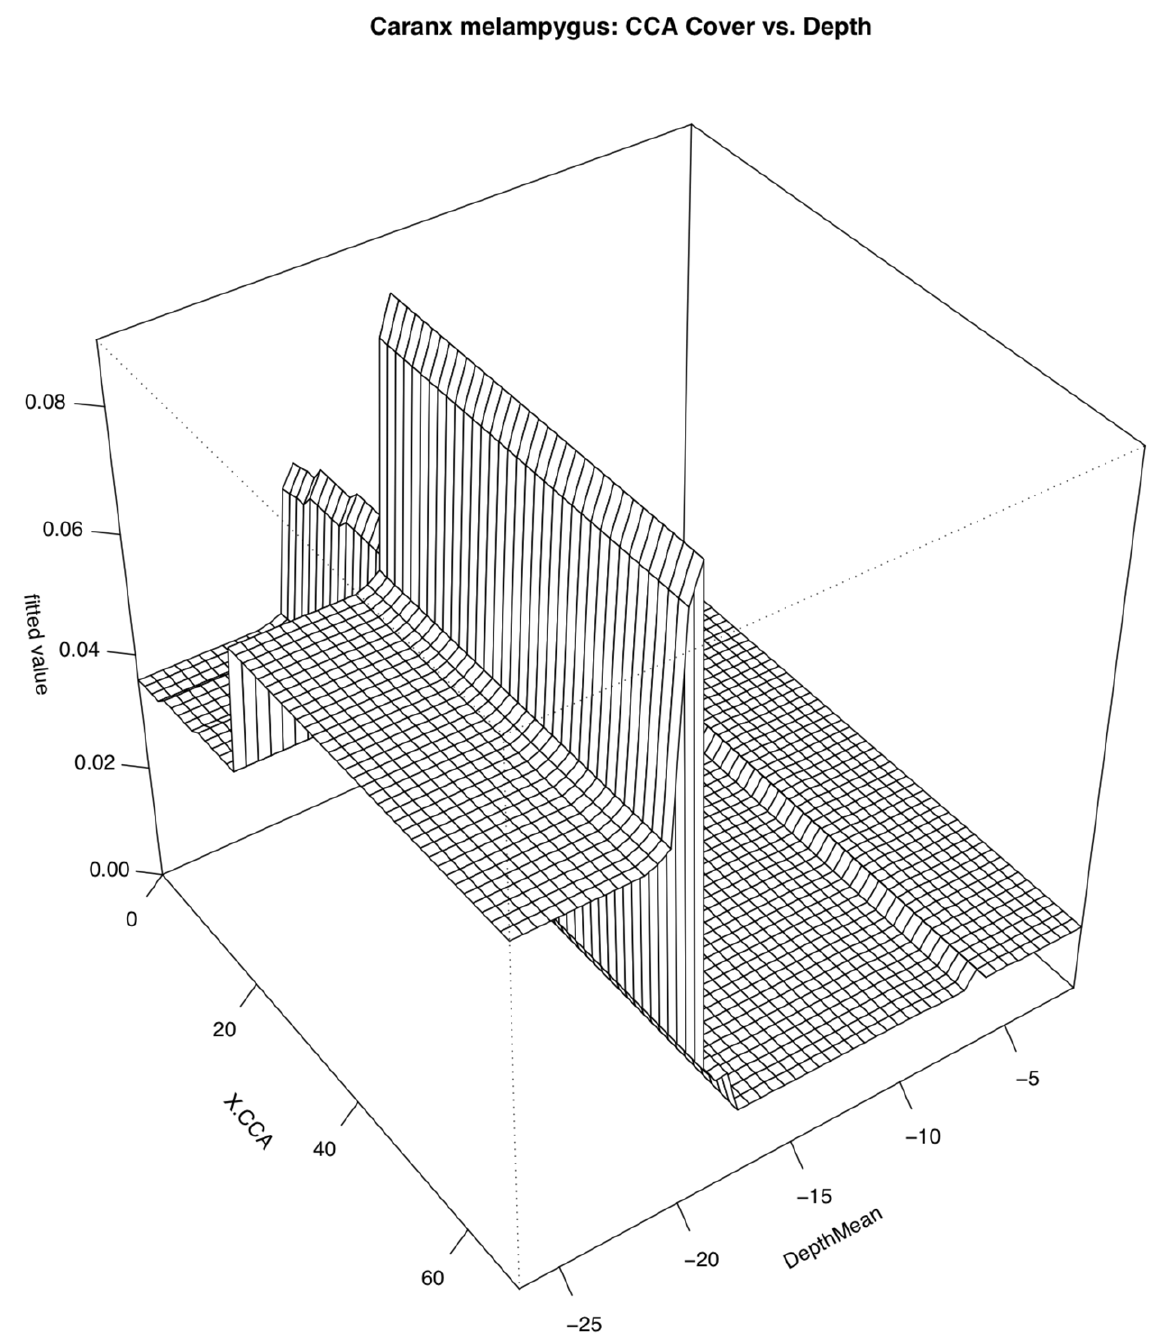
Figure 13. Pairwise interaction between depth and percent cover of crustose coralline algae (CCA) with respect to occurrence of Caranxmelampygus . The effect of CCA was greatest at depths greater than 15 m while the effect of depth was reduced in areas with lower CCA cover.